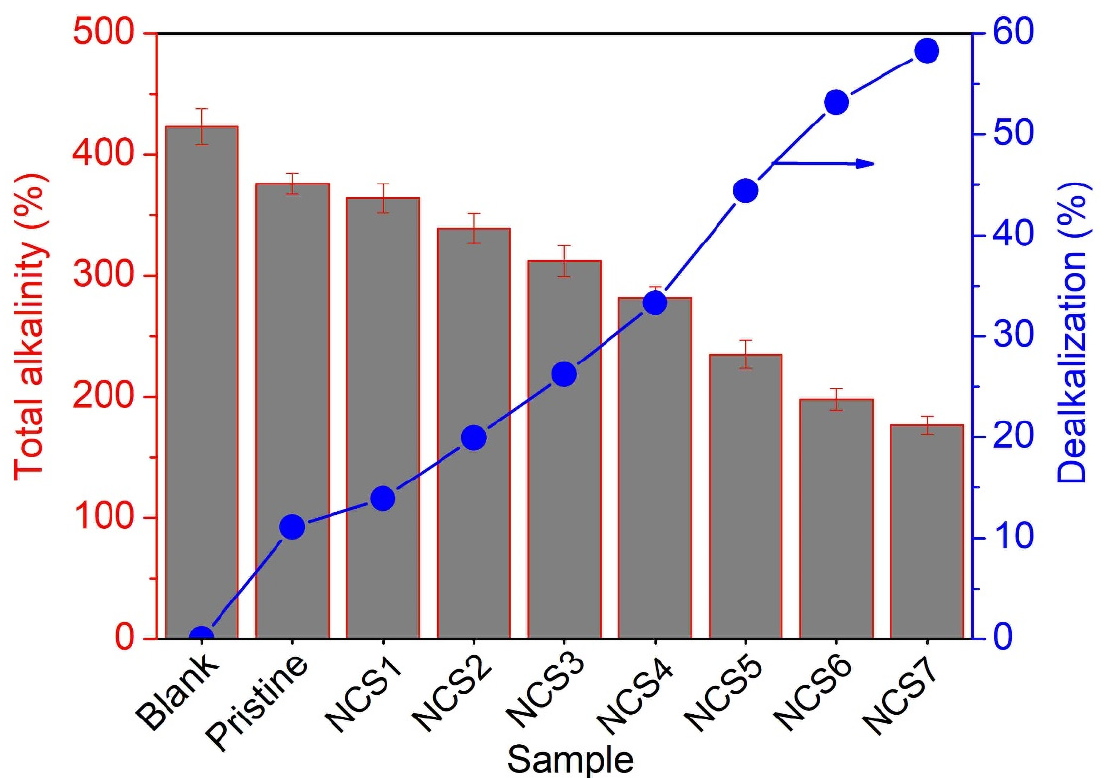
Figure 7. Total alkalinity and dealkalization of wastewater before and after coagulation/flocculation treatment by chitosan bulk and nanoparticles.